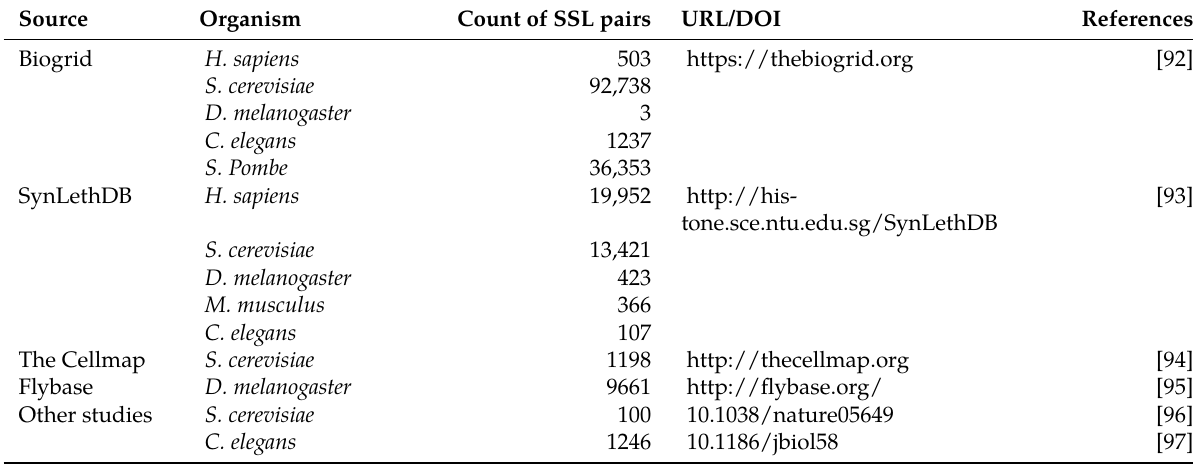
Table 2: Synthetic lethal interaction data availability.